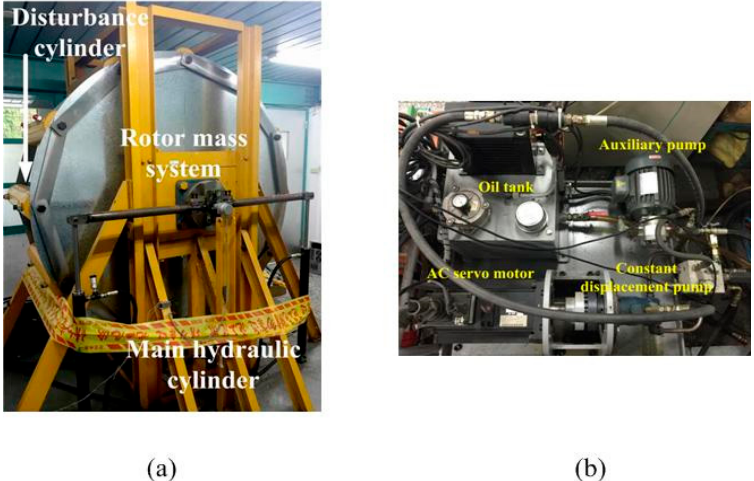
Figure 2. Test rig of novel variable pitch control system of wind turbine driven by hydraulic pump ‐ controlled dual ‐ cylinder system.